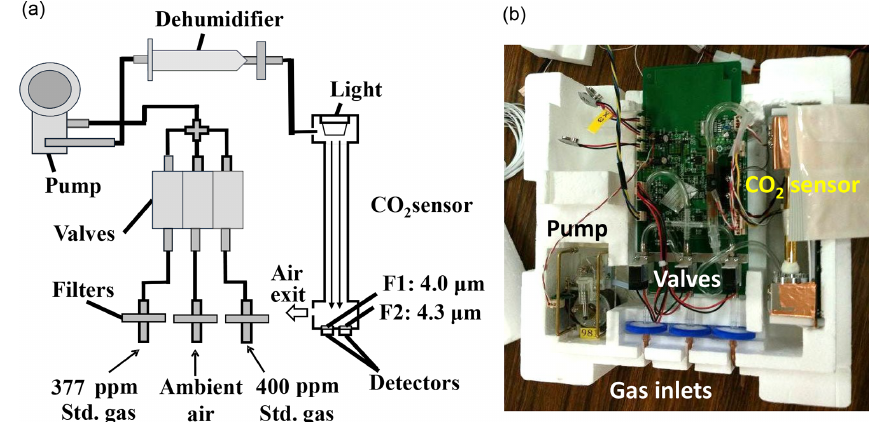
Figure 1. (a) Schematic diagram of the CO 2 measurement package, where F1 and F2 represent the band-pass filters at wavelengths of 4.0 and 4.3µm, respectively. The outlet port of the CO 2 sensor is opened to ambient air. Details of the system are described in the text. (b) Photograph of the inside of the CO 2 sonde package. The components were placed in a specially modeled expanded polystyrene box.